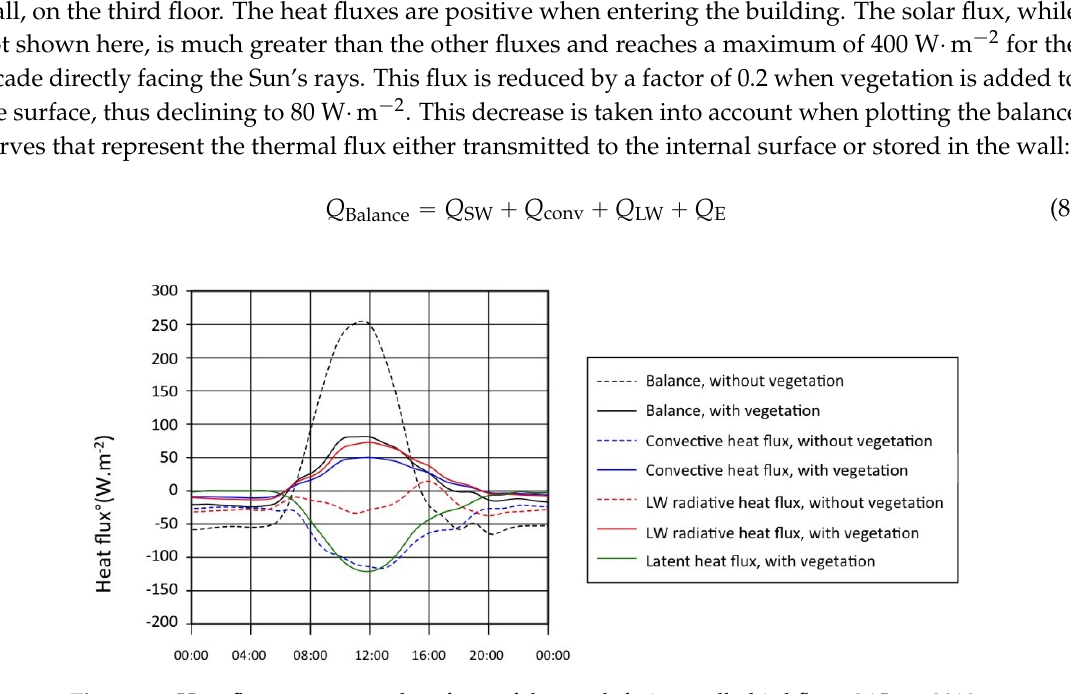
Figure 11. Internal surface temperature of windows and walls, mean radiant temperature (MRT) and indoor air temperature ( T air ) of the third floor on 26 June 2010. It can be observed that the internal surface temperature is high in the absence of any greening or insulation, allowing it to reach 40 °C, thus providing a sense of the extent of heat transmission by conduction. This finding can be explained by the low albedo values (0.25) and thermal resistance of the walls. The maximum internal surface temperature of the windows is lower because less solar flux